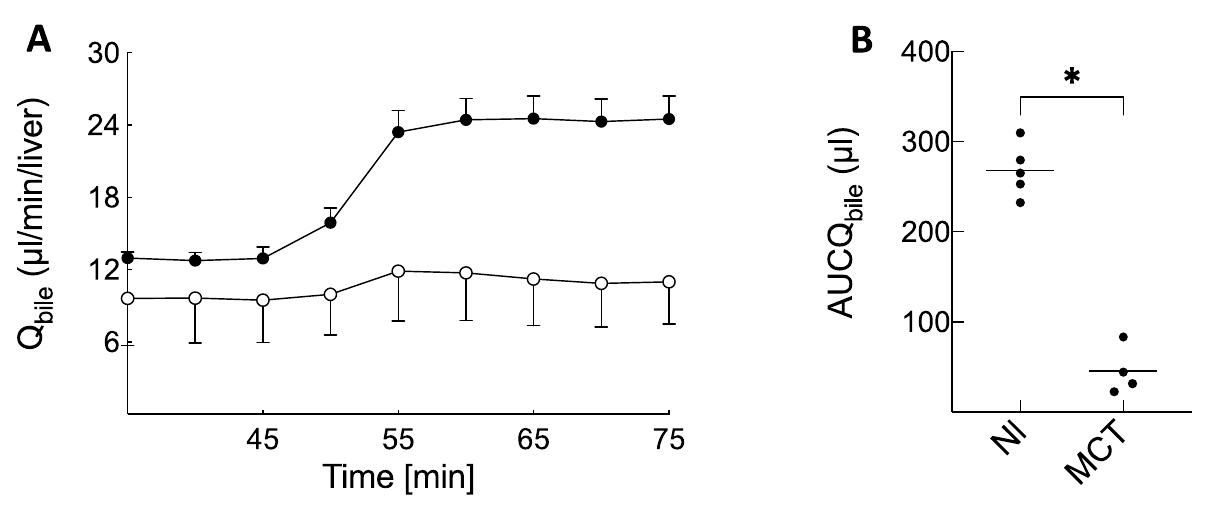
Figure 2. ( A ) Bile flow rates (Q bile ) during BOPTA perfusion (45 to 75 min). Livers were perfused with Krebs–Henseleit bicarbonate solution (KHB) + 200 µ M [ 153 Gd]BOPTA. Normal liver (Nl, black circles) and MCT livers (white circles). ( B ) Area under the curve of Q bile (AUCQ bile ) increase during BOPTA perfusion. * p = 0.02.